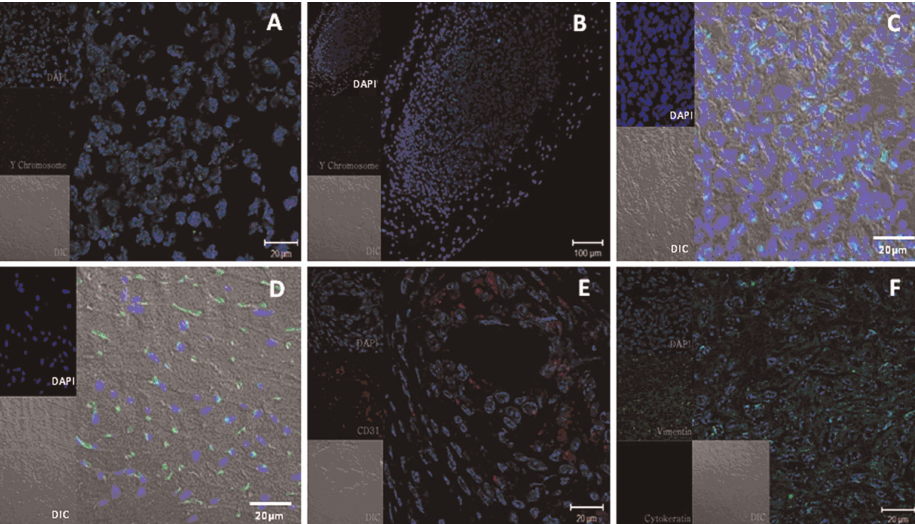
Figure 6. Confirmation of the allografted quasi-natural cell block in the recipient body. To confirm allogenicity of the transplanted quasi- natural cell block, gender-specific probes were used to distinguish the male-derived allografted tissue from the recipient female mouse by FISH along with DAPI staining of the nucleus ( A, B ). Green spots indicate male Y chromosome probe in the corresponding female tissue. For intercellular communication capability in the allografted tissue, specimens were stained with specific probes for signaling marker connexin43, in the quasi-natural tissue ( C ) along with native heart tissue ( D ). Immunostaining of the allografted quasi-natural tissue with epithelial linage marker CD31 revealed vascular network assembly as indicated ( E ). Immunostaining of the allografted quasi-natural tissue further showed that most of cells were stained with anti-vimentin, mesodermal lineage marker, but not with anti- cytokeratin ( F ). Images for individual channels (connexin43 with alexa 488 is green, cd31 with alexa 568 is red, vimentin with alexa 488 is green, cytokeratin with alexa 568 is red) are shown on the left, and main panels show the merged image containing all channels plus DIC. The cells nuclei were visualized with DAPI (blue). Scale bar: ( A, C, D, E and F ) 20 m m; ( B ) 100 m